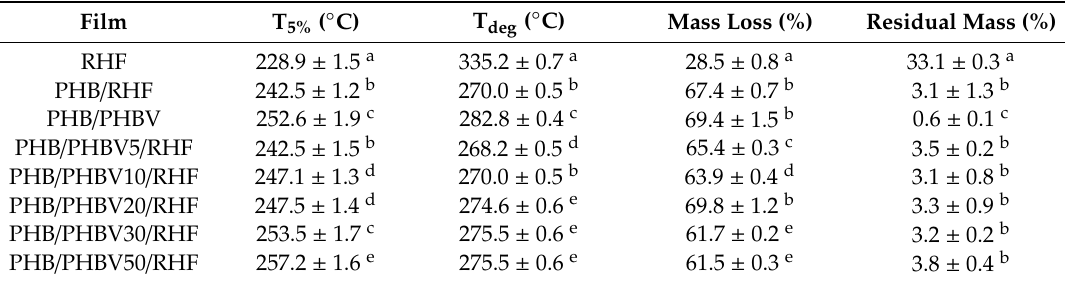
Table 4. Main thermal parameters of the thermo-compressed films made of poly(3-hydroxybutyrate) (PHB), poly(3-hydroxybutyrate- co -3-hydroxyvalerate) (PHBV), and rice husk flour (RHF) in terms of: onset temperature of degradation (T 5% ), degradation temperature (T deg ), mass loss at T deg , and residual mass at 800 ◦